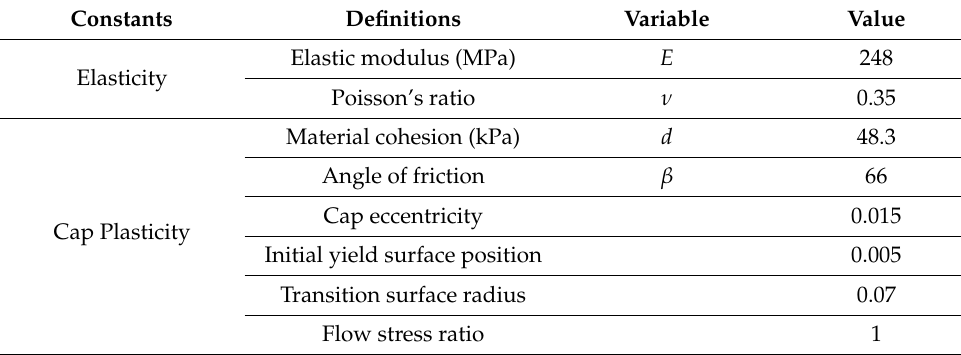
Table 2. The MDPC parameters of the base course layer.